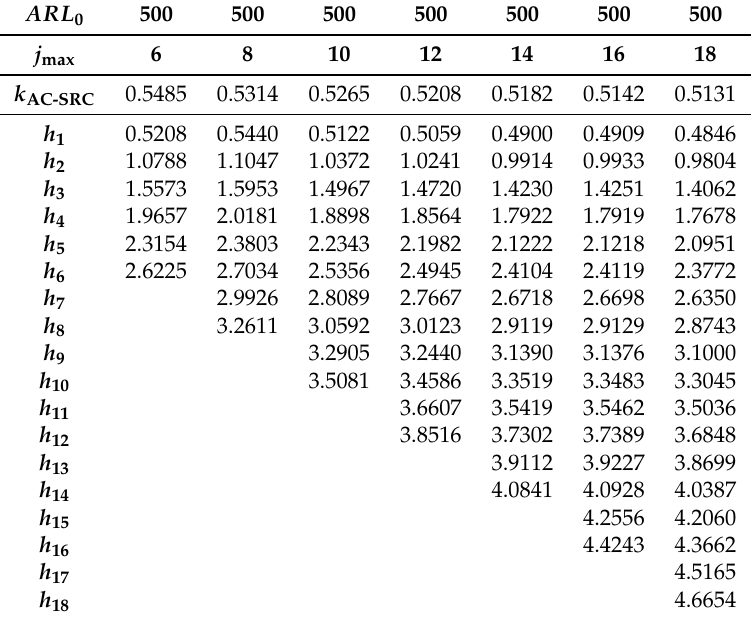
Table A6. AC-SRC for ARL 0 = 500.